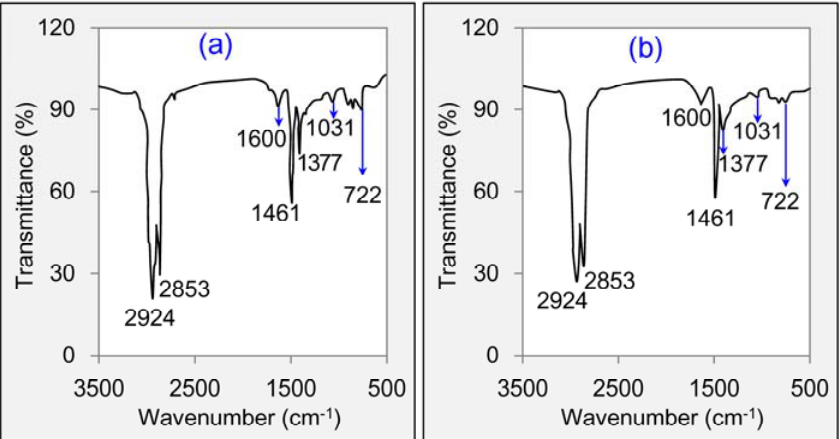
Figure 12. FT-IR analysis results: ( a ) Base asphalt, ( b ) RMA.